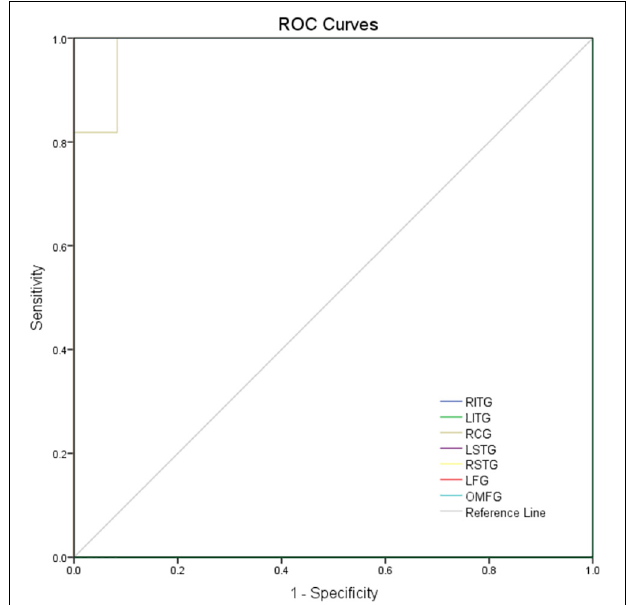
FIGURE 3 | ROC curve analysis of the mean ReHo values for altered brain regions. The area under the ROC curve were 1.000, ( p <0.0001; 95% CI: 1.000–1.000) for LITG, RITG, LSTG, RSTG, LFG, and OMFG; 0.985 ( p < 0.01; 95% CI: 0.946–1.000) for RCG. AUC, area under the curve; ROC, receiver operating